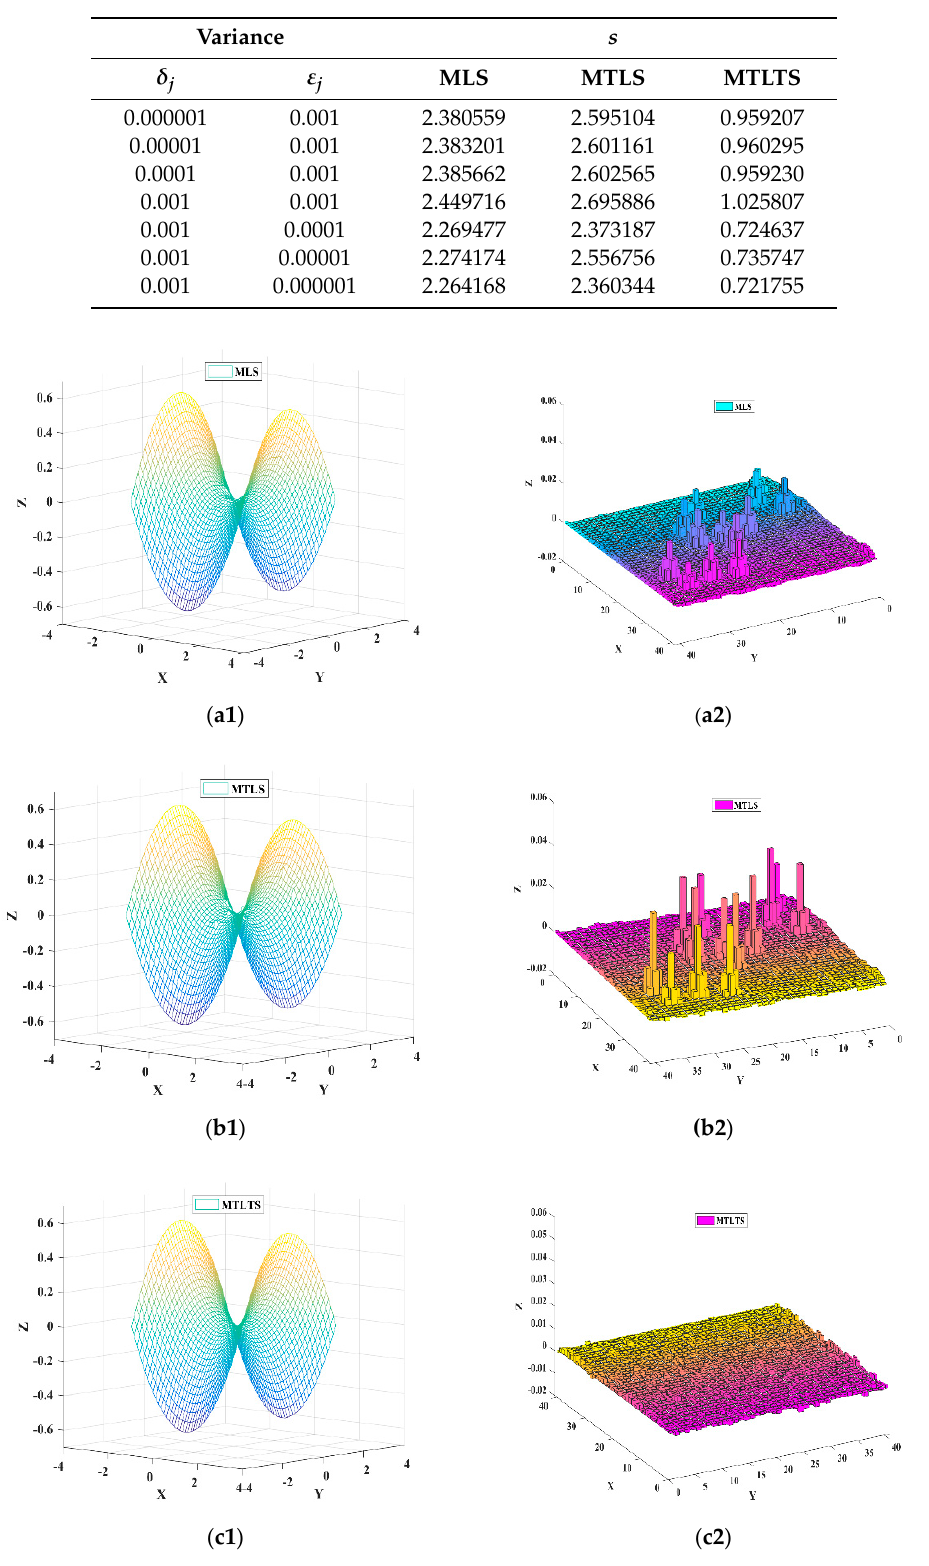
Table 3. The fitting results by three methods in Case 2.